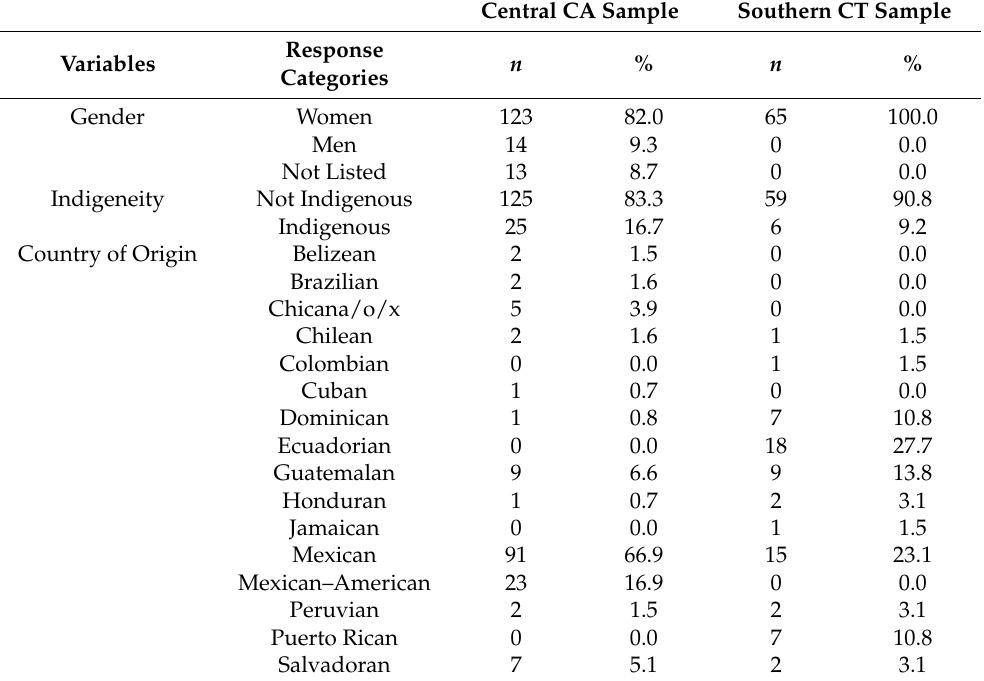
Table 1. Demographic Summary for Each Study